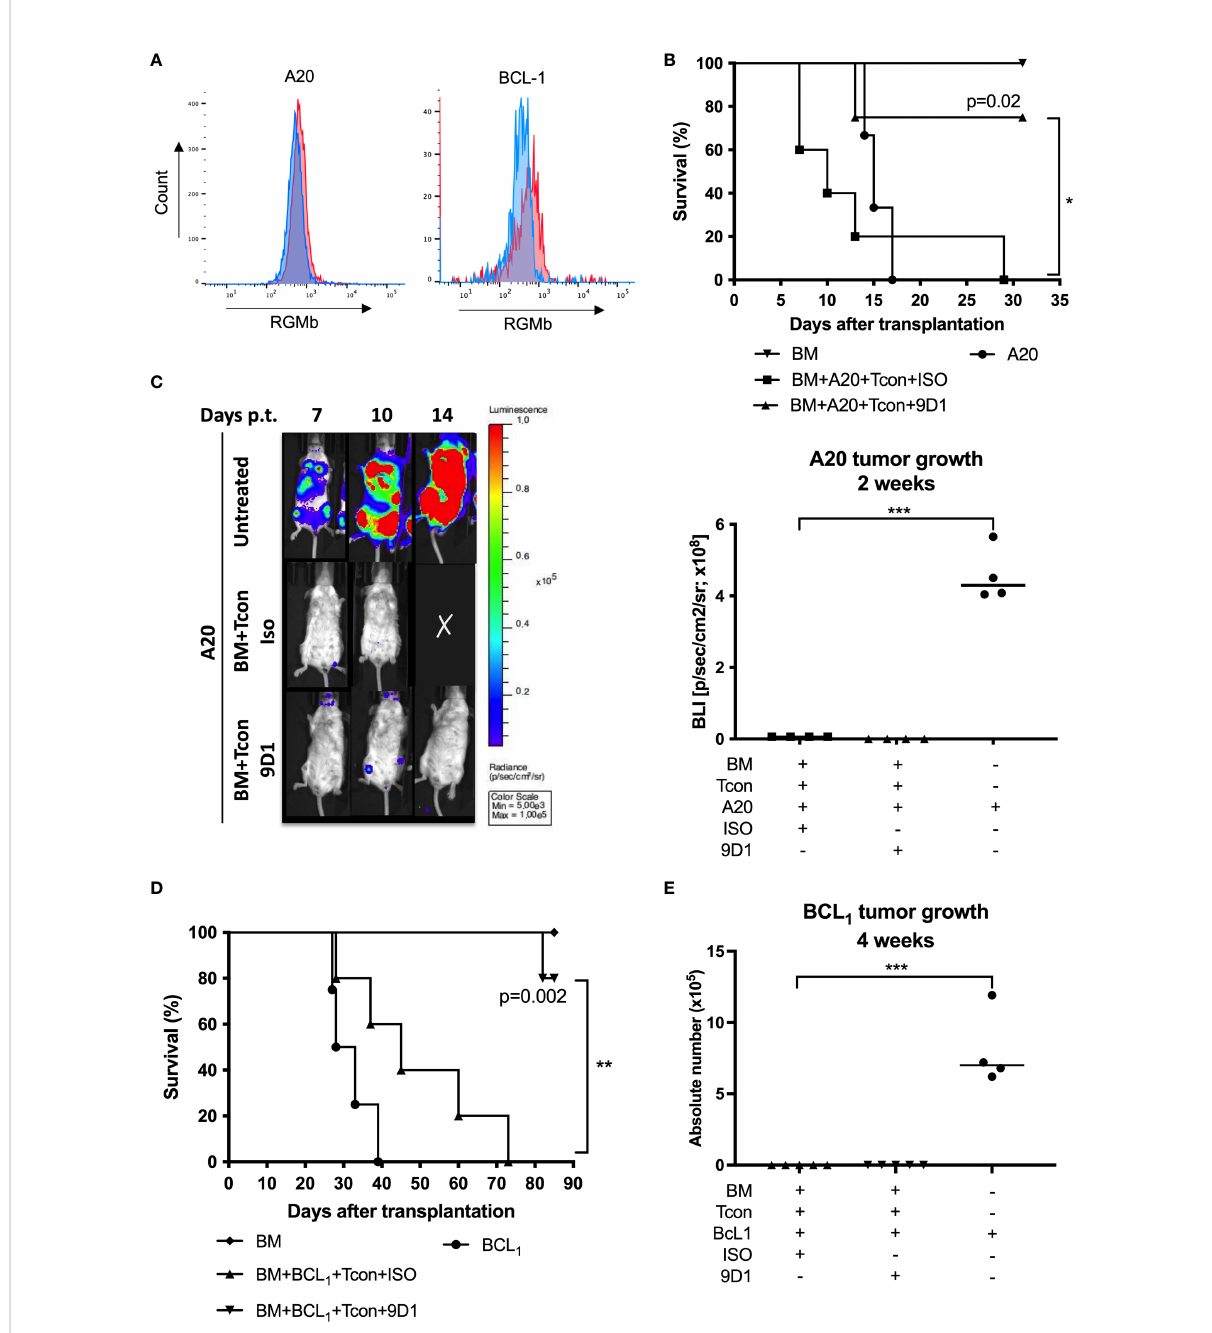
FIGURE 3 Anti-RGMb antibody 9D1 therapy enhanced survival in graft-versus-tumor model. (A) Overlay of a negative population (Blue) onto the stained population (Red) allows easy identi fi cation of the RGMb expression on A20 or BCL1 cells. (B) Mice survival was monitored for 31 days after A20 transplantation on isotype control and 9D1-antibody-treated mice (20 mg/Kg; i.p.). (C) Representative images and quanti fi cation of signals were done using a living imaging program. Results are expressed as mean ± SEM (n ≥ 4/group). (D) Mice survival was monitored for 80 days after BCL1 transplantation. (E) Tumor growth was monitored by fl ow cytometry 4 weeks after BCL1 transplantation. * p ≤ 0.05, ** p ≤ 0.01, *** p ≤ 0.001, One- way ANOVA